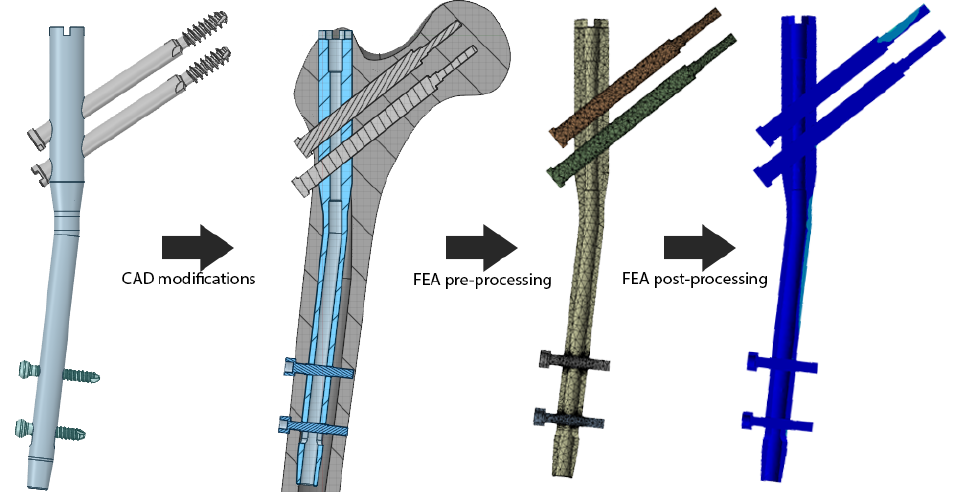
Figure 3. Workflow diagram.